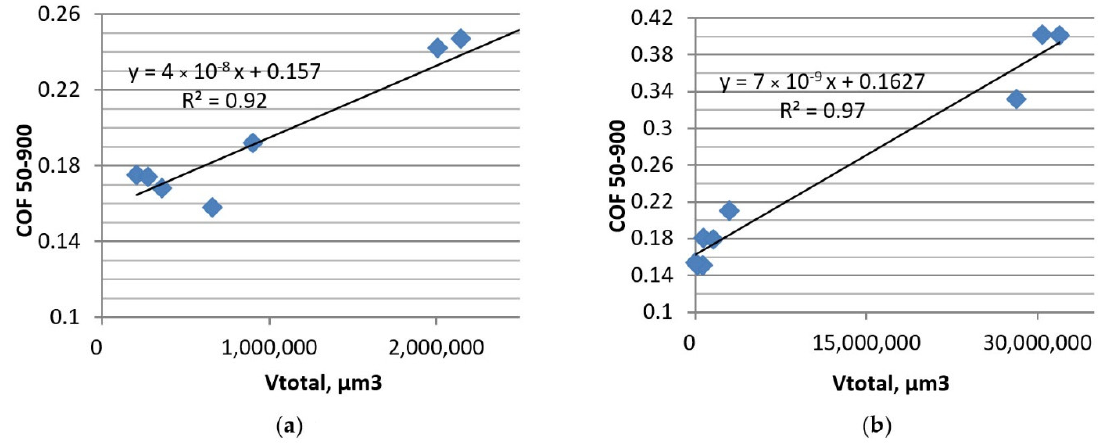
Figure 16. Average coefficients of friction versus volumetric wear of the tribological system in tests: B ( a ) and B1 ( b ).